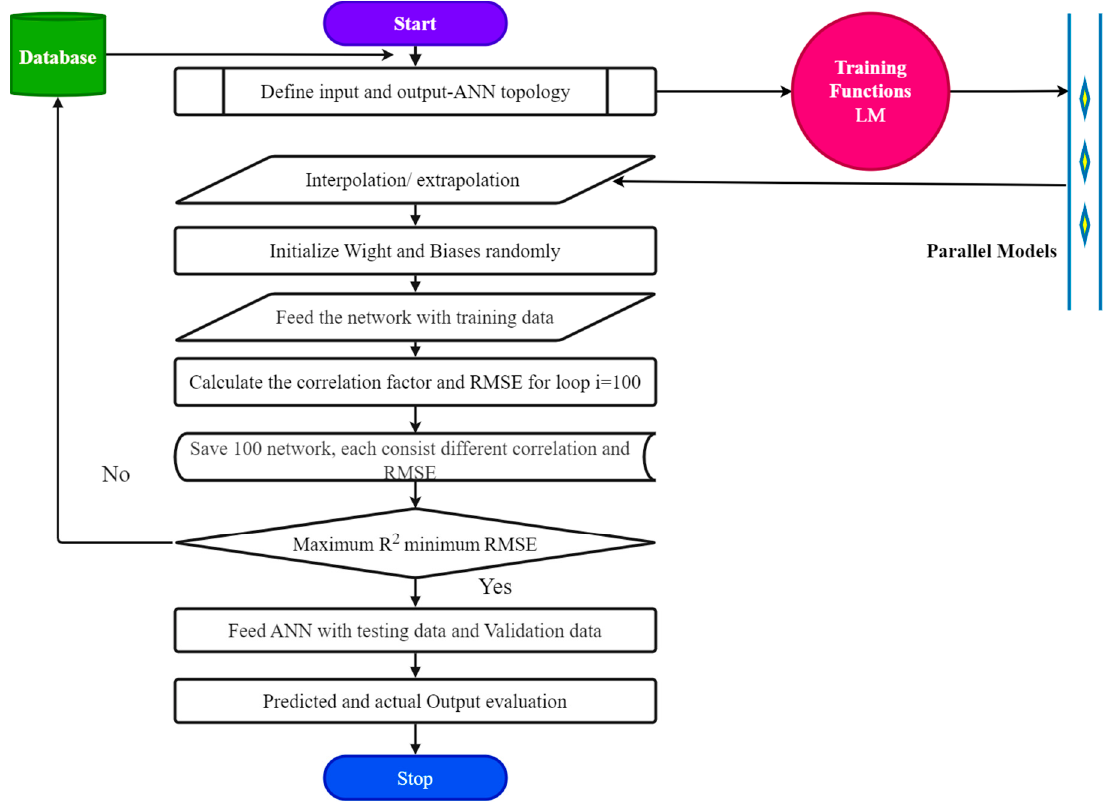
Figure 3. ANN flowchart for the UCS and E prediction model.